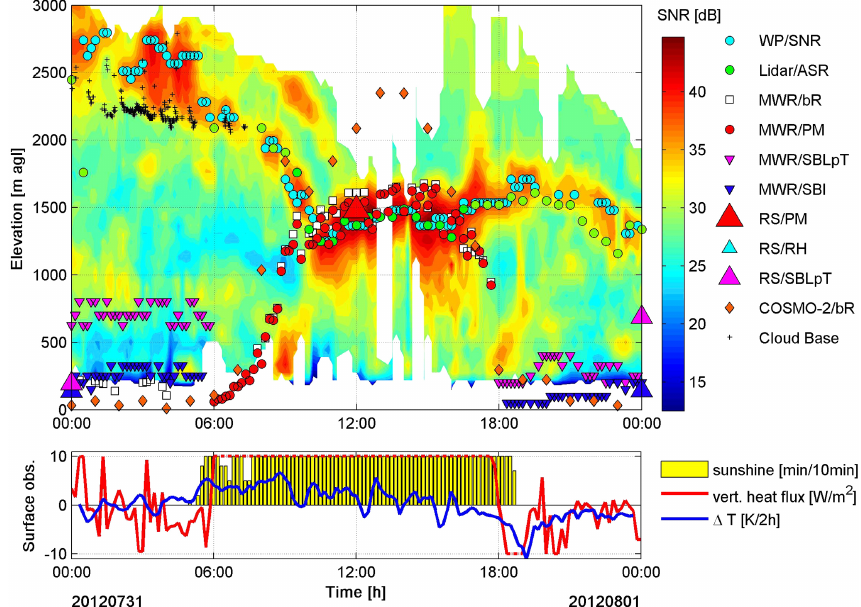
Figure 8. Example of CBL overestimation by COSMO-2/bR, the background signal corresponds to the WP/SNR. For a description of the symbols, see Fig. 4.